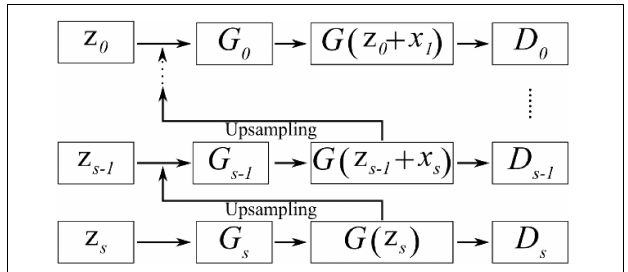
FIGURE 7 | Schematic diagram showing the pyramid structure in SinGAN’s generator and discriminator.